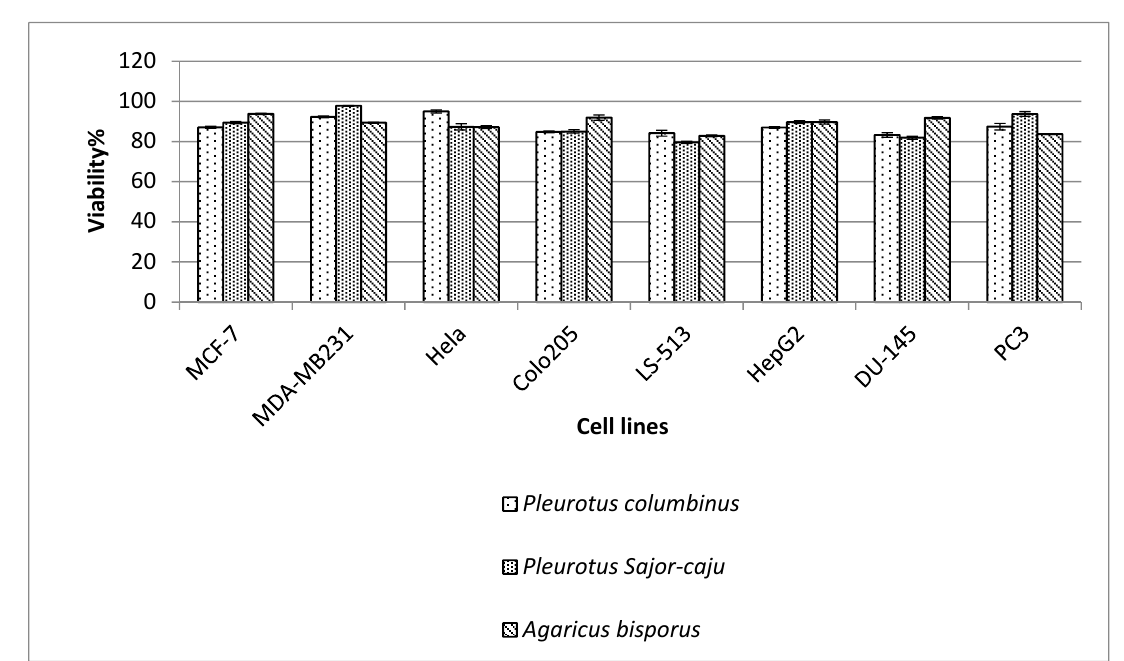
Figure 3. Cytotoxic effect of the three mushrooms extracts Pleurotus columbinus , Pleurotus sajor - caju , and Agaricus bisporus against cancer cell lines MCF-7, MDA-MBA-231, Hela, Colo-205, LS-513, HepG2, Du-145, and PC-3.